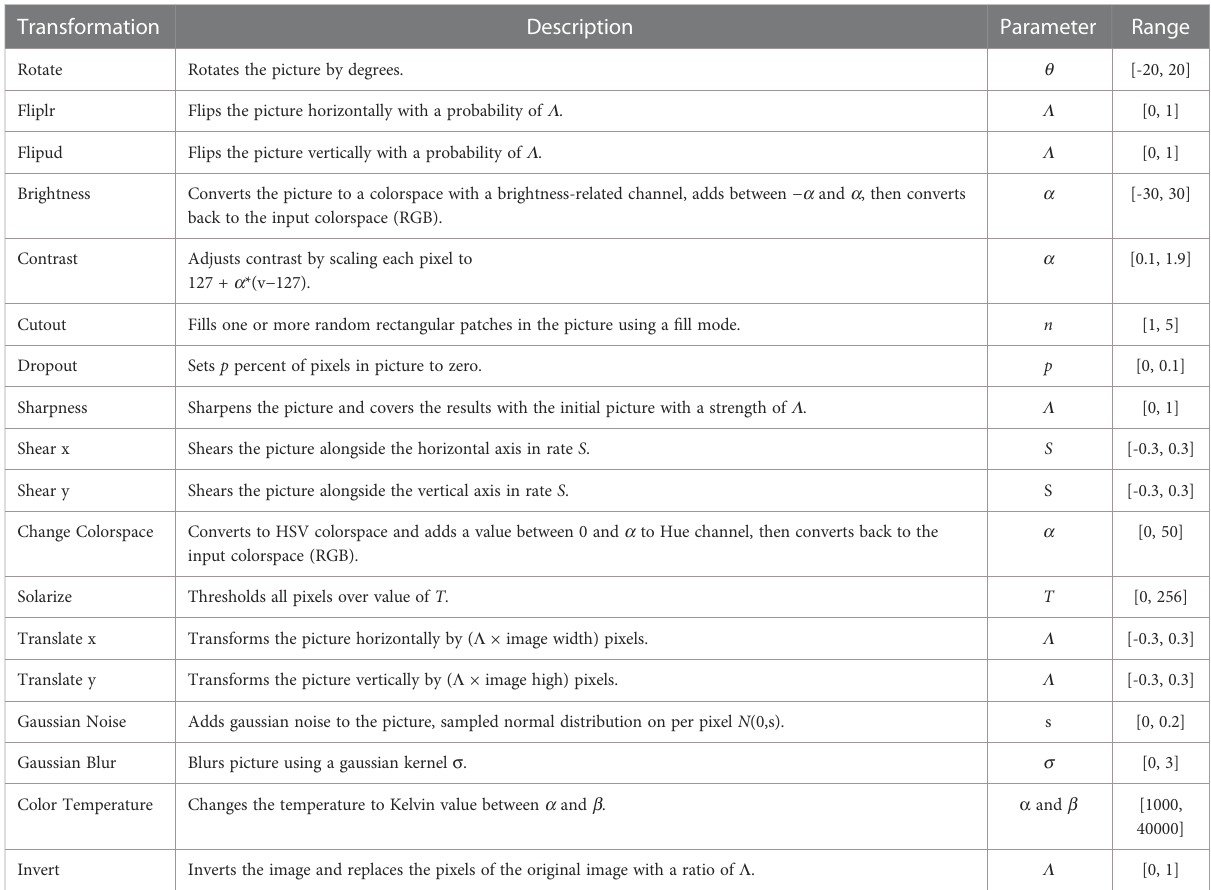
TABLE 1 Transformations available in Semi-His-Net. Transformation Description Rotate Rotates the picture by